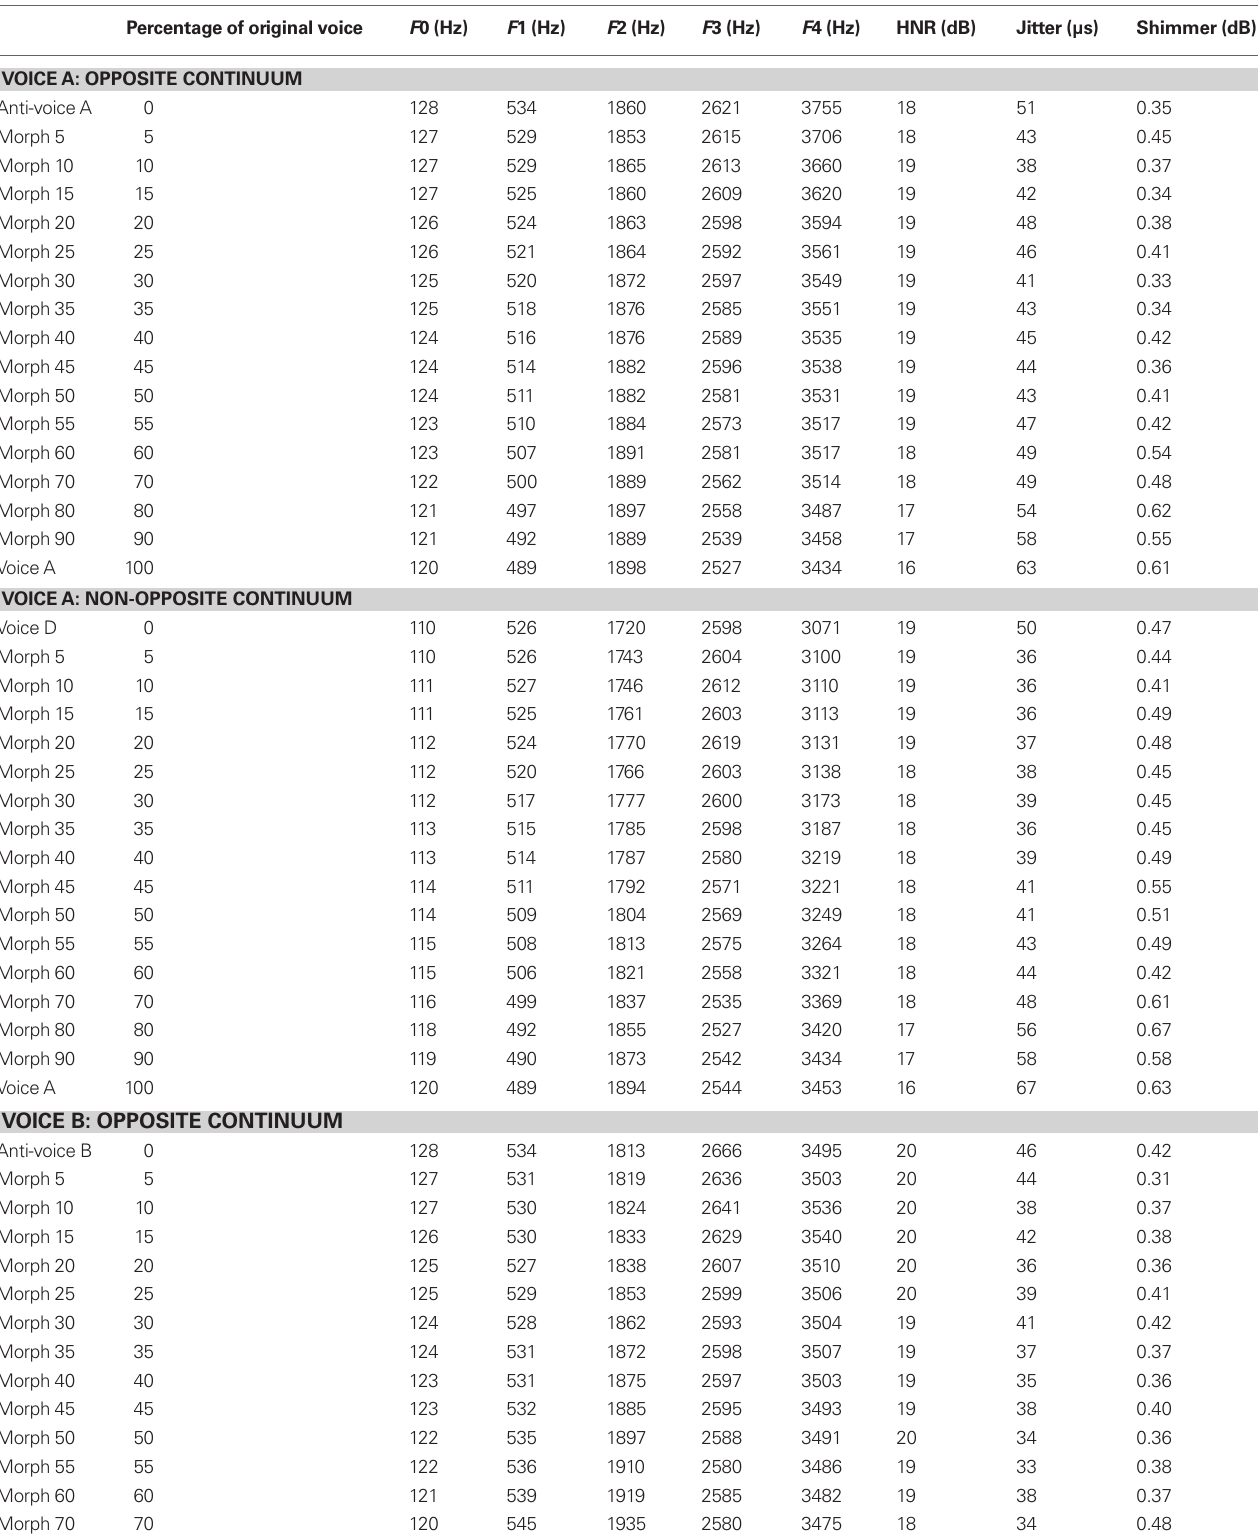
Table 2 | Acoustic parameters of the stimuli used in experiment 2. Percentage of original